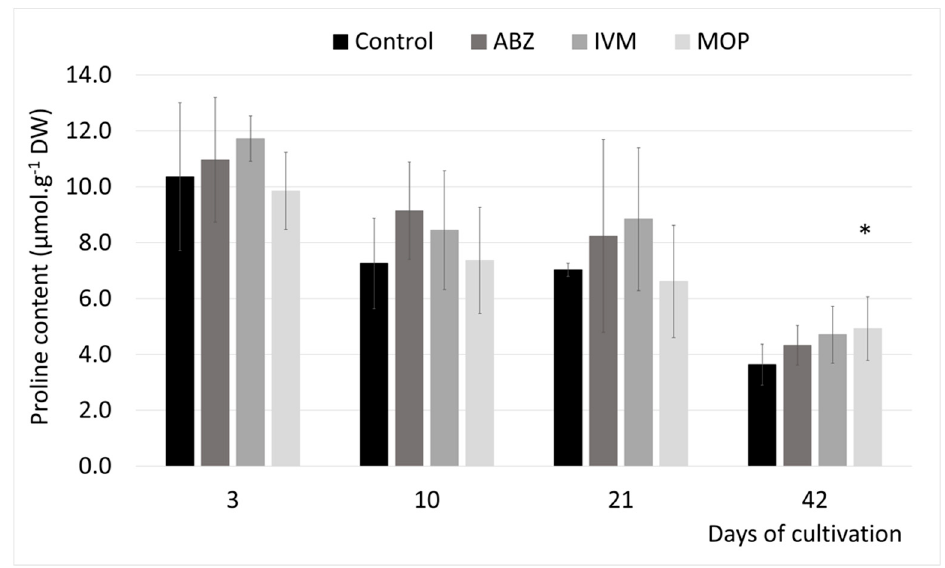
Figure 2. Changes in proline accumulation in T. pratense shoots cultivated with the manure of sheep treated with albendazole (ABZ), ivermectin (IVM) or monepantel (MOP) in time. The data are expressed as mean ± SD, n = 3. Asterisks mark statistically significant differences comparing to control up to alpha ≤ 0.05.